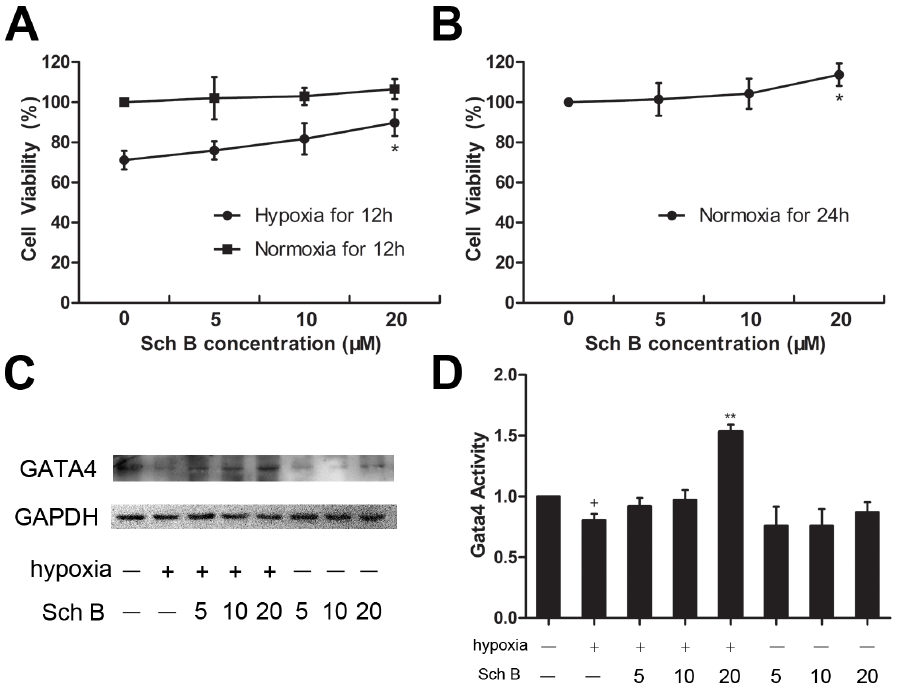
Figure 9. Sch B in the effects of increasing cell viability in H9c2 cells. (A) Cell viability determined by MTT assay after hypoxic injury or normoxic for 12 hours pre-treatment with Sch B induced concentrations-dependent increases in survival of H9c2 cells. (B) Cell viability determined by MTT assay for 24 hours in normoxia condition pre-treatment with Sch B induced concentrations-dependent increases in survival of H9c2 cells. n=6 per group, * P , 0.05 versus 0 m M Sch B group. (C) Western blot analysis of GATA4. (D) Densitometry for GATA4 expression normalized to GAPDH. n=3 per group, * P , 0.05 versus hypoxia ( + ) and Sch ( 2 ) group, ** P , 0.01 versus hypoxia ( + ) and Sch ( 2 ) group, + P , 0.05 versus hypoxia ( 2 ) and Sch ( 2 ) group, ++ P , 0.01 versus hypoxia ( 2 ) and Sch ( 2 )